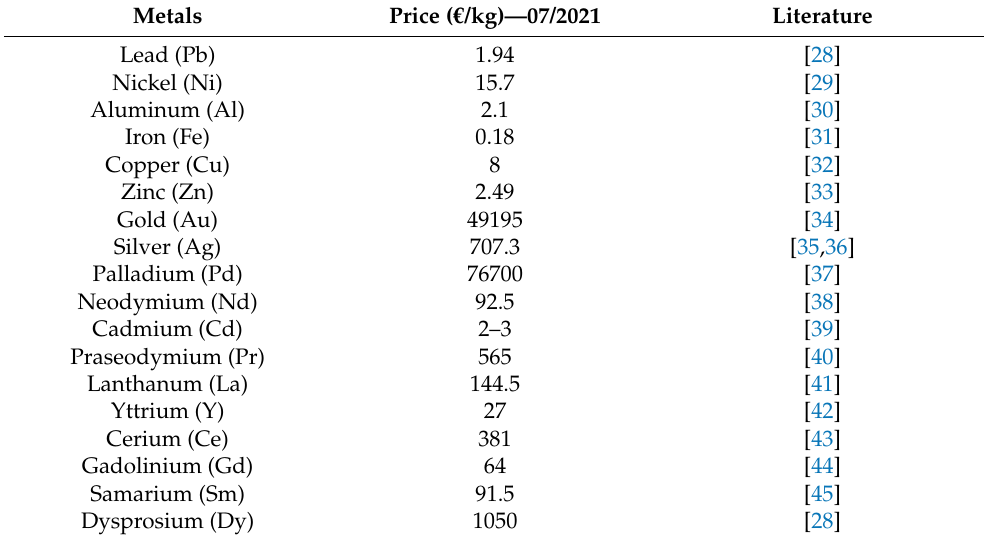
Table 3. Price of metals found in